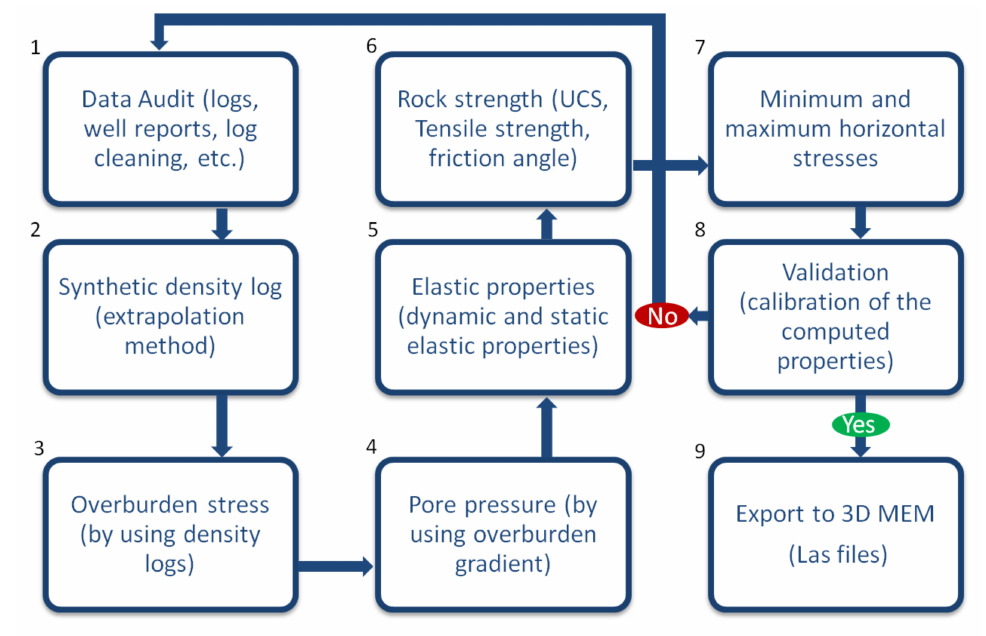
Figure 2. Step by step 1D MEM workflow for computing material properties and horizontal